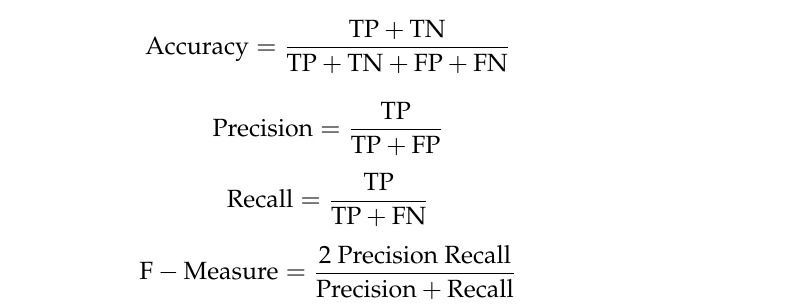
Figure 8. Learning curves of the SqueezeNet DL method.